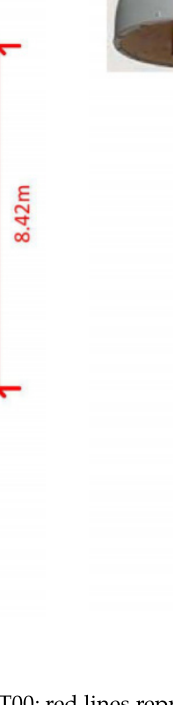
Figure 3. ( a ) Location of station CUT00; red lines represent the spacing distance from other stations; ( b ) manufacturer and type for three receivers (CUT0, CUT2, and CUT3). (http://saegnss2.curtin.edu/ldc/CU-GNSS-receivers-setup.pdf, accessed on 1 December 2021).